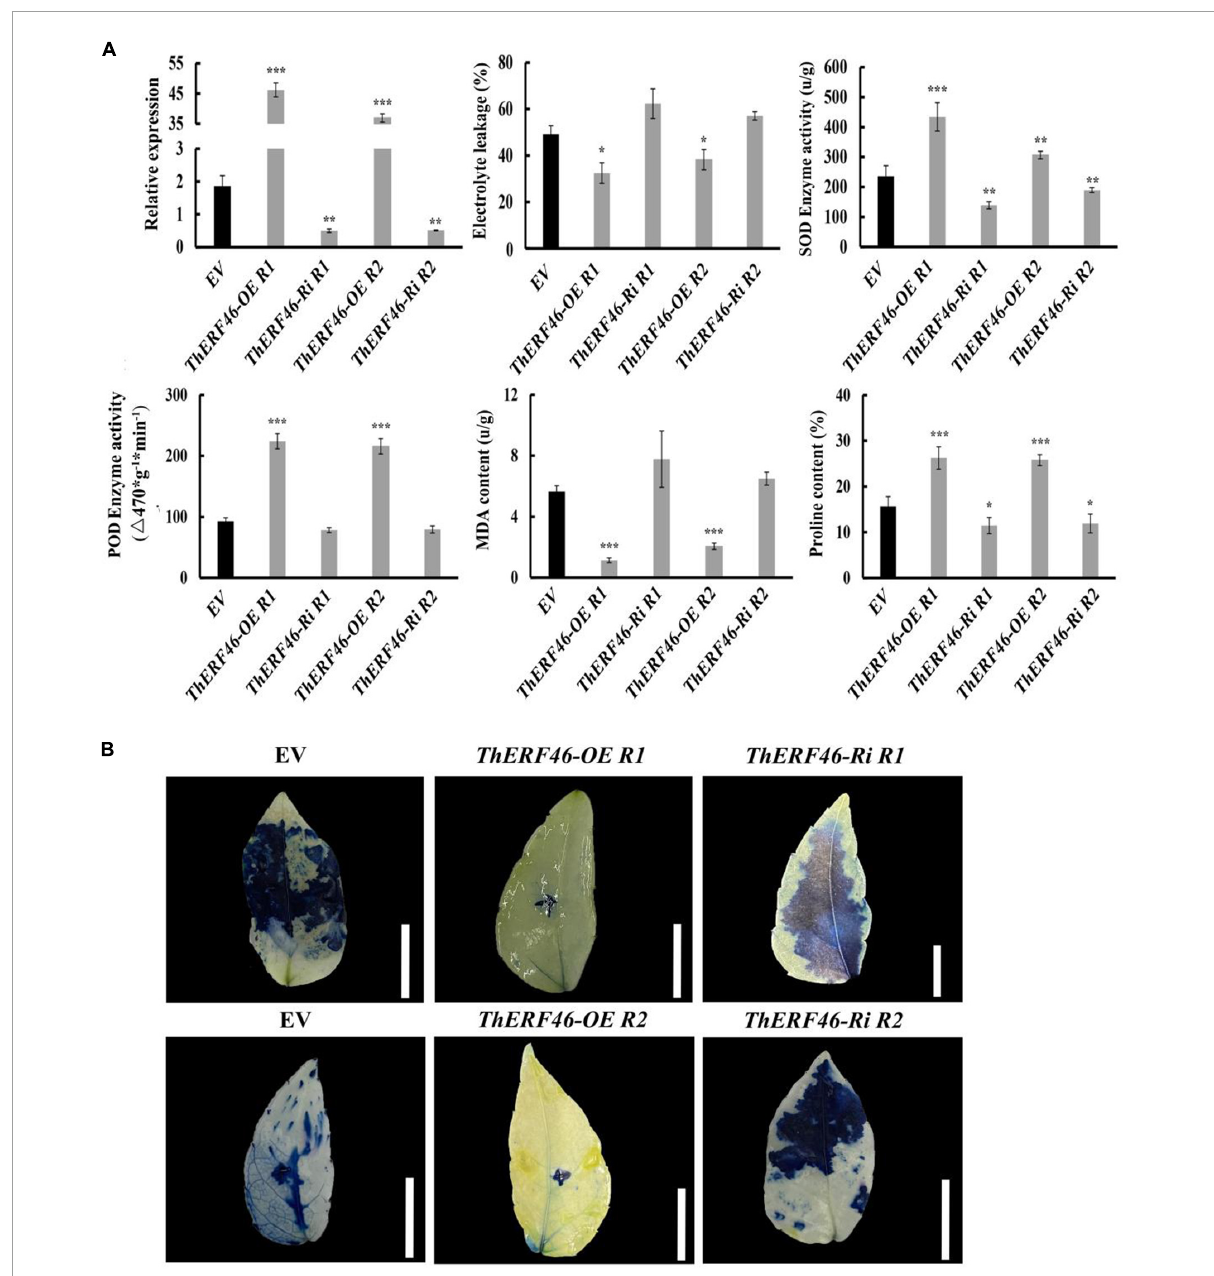
FIGURE5 Analysis of the biochemical indexes of ThERF46 in T. hemsleyanum. (A) Analysis of the physiological indexes of T. hemsleyanum . (B) Analysis of cell activity of T. hemsleyanum . EV, empty vector (the EV without an exogenous gene was used as the control); R1, Repeat 1; R2, Repeat 2. Data are means ± standard error of the three biological replicates for each treatment. Bar, 1 cm. * P ≤ 0.05, ** P ≤ 0.01, *** P ≤ 0.001.